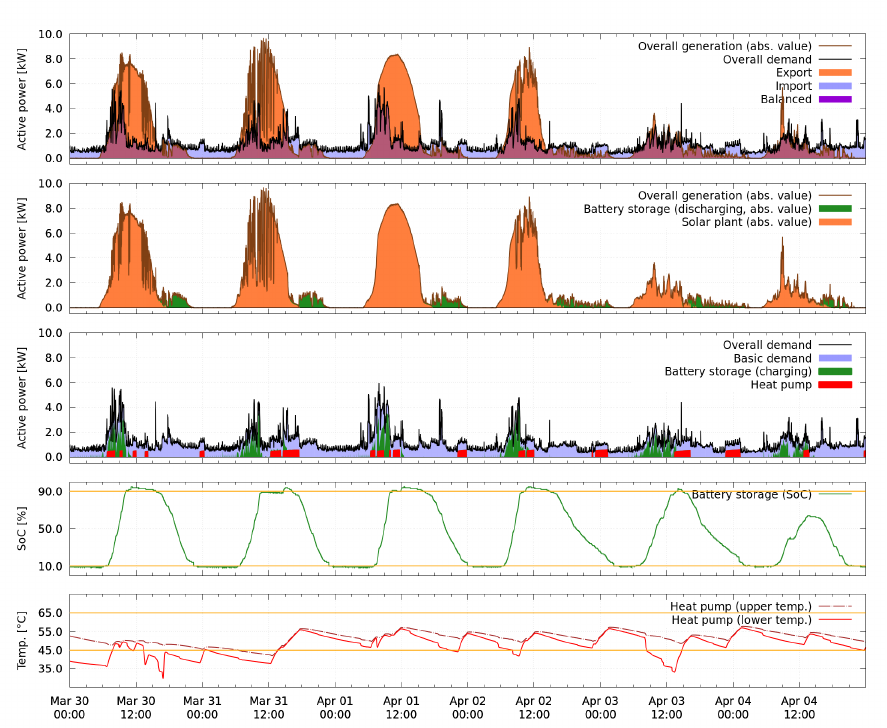
Figure 16. Experimental results from the demonstration site for 30 March to 4 April (measured history).